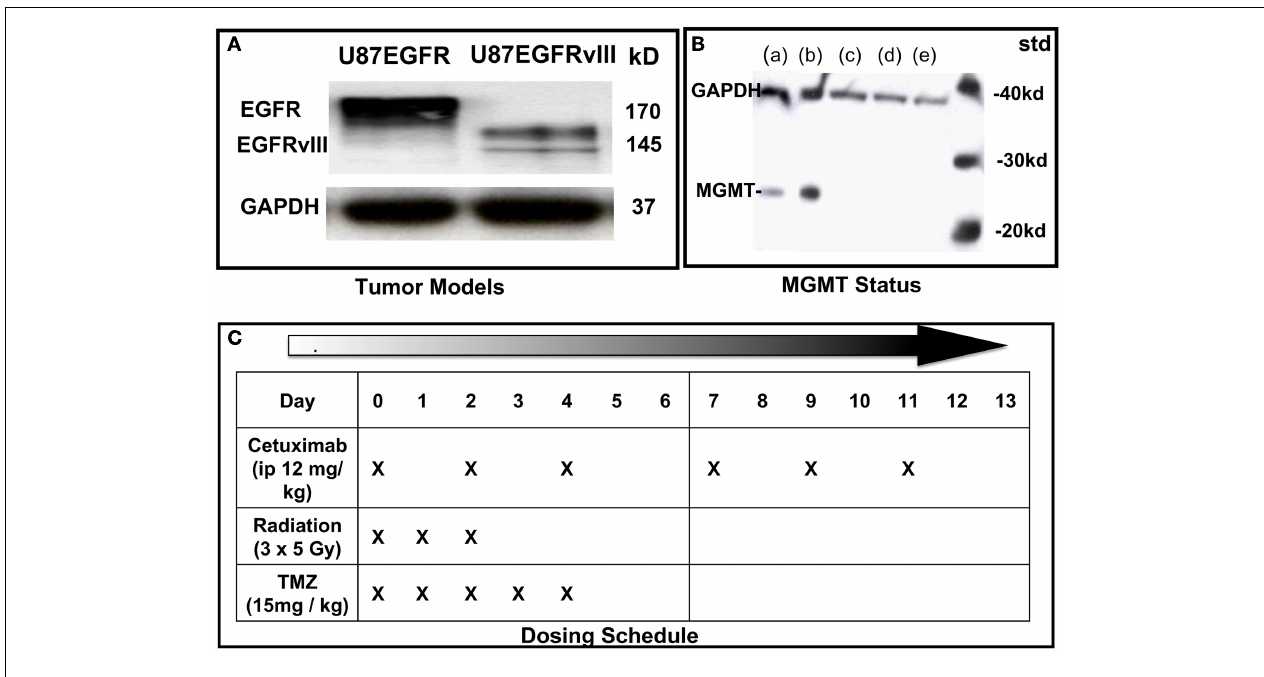
(b) = MGMT positive control; (c) = U87wtEGFR; (d) = U87EGFRvIII; (e) = U87 parent. (C) Dosing schedule. Mice were randomized into eight experimental groups (10–15 animals per